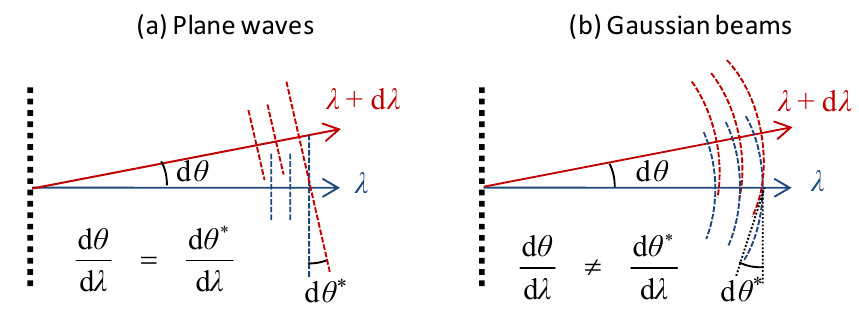
Figure 3. Comparison of the two types of angular dispersion in the case of plane wave and Gaussian beam